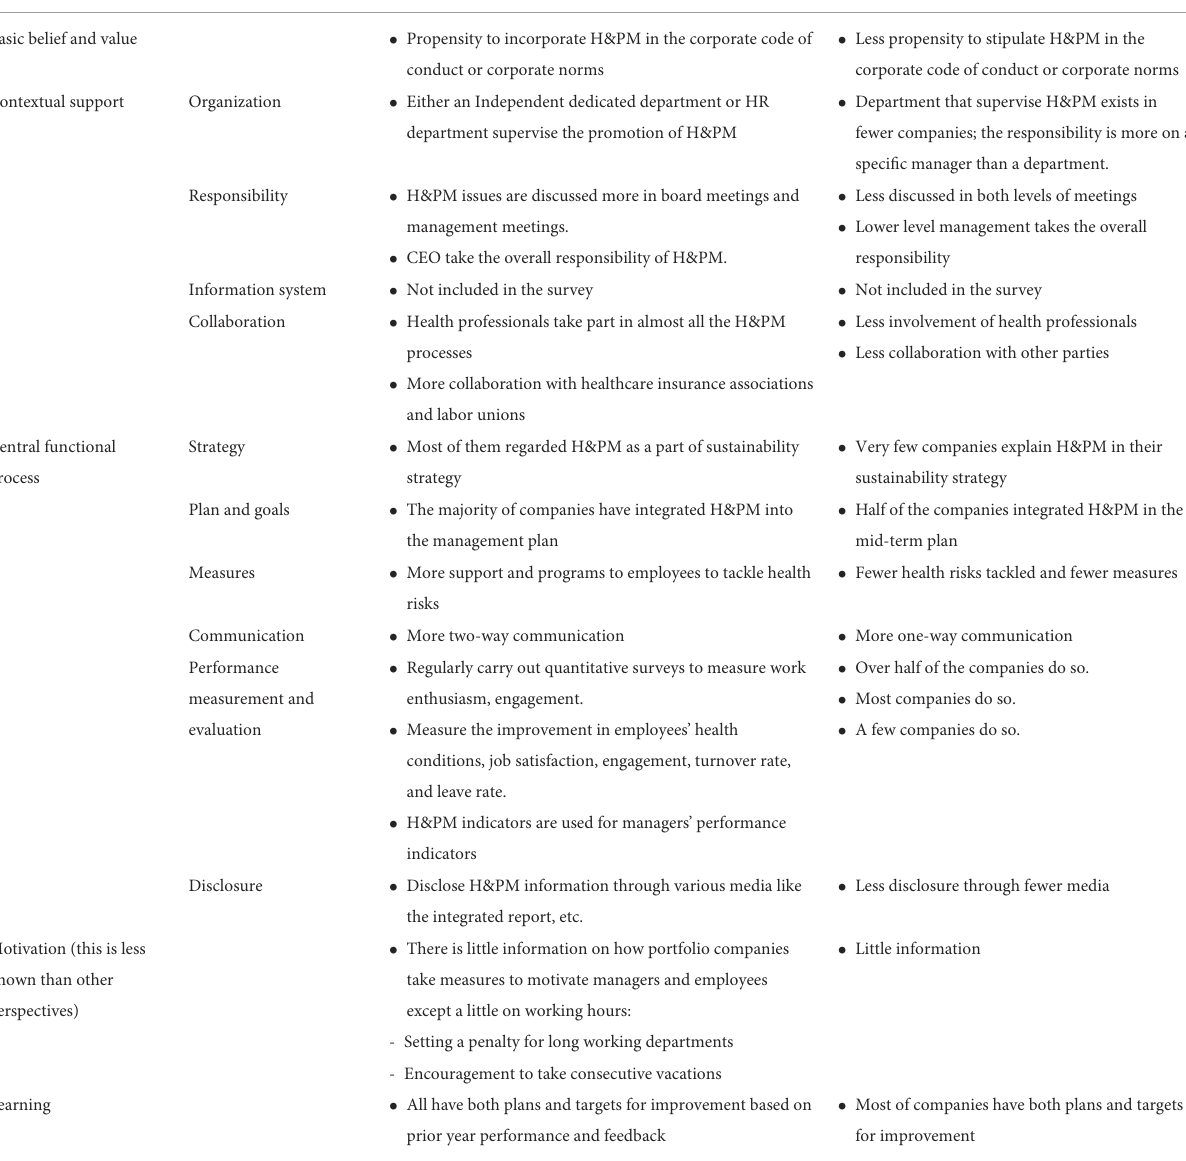
TABLE 3 H&PM of portfolio and non-portfolio